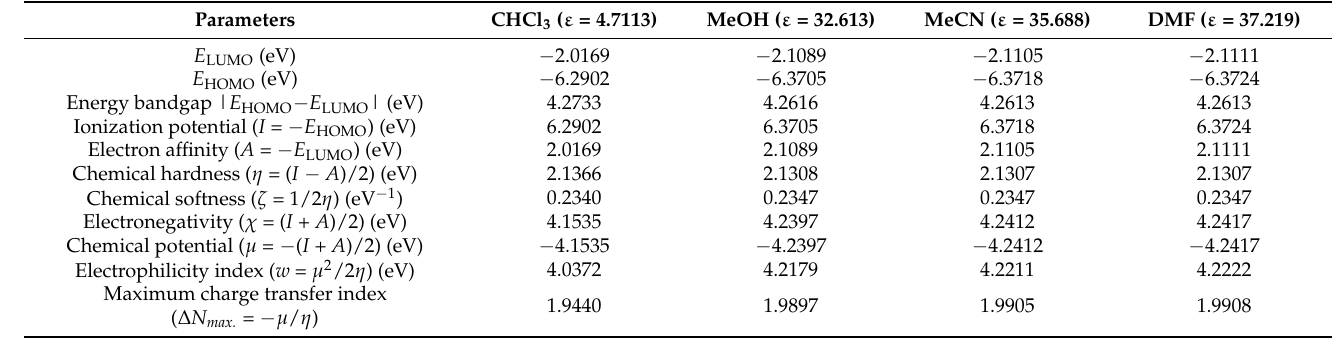
Table 5. Some quantum chemical molecular descriptors computed for 2 in different solvents.